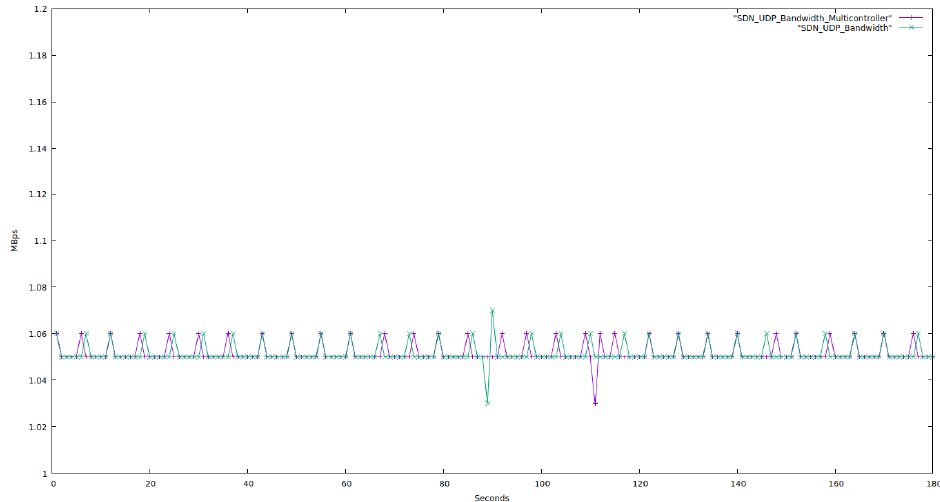
Figure 14. UDP bandwidth fluctuation of single-controller SDN vs. Multi-controller SDN.